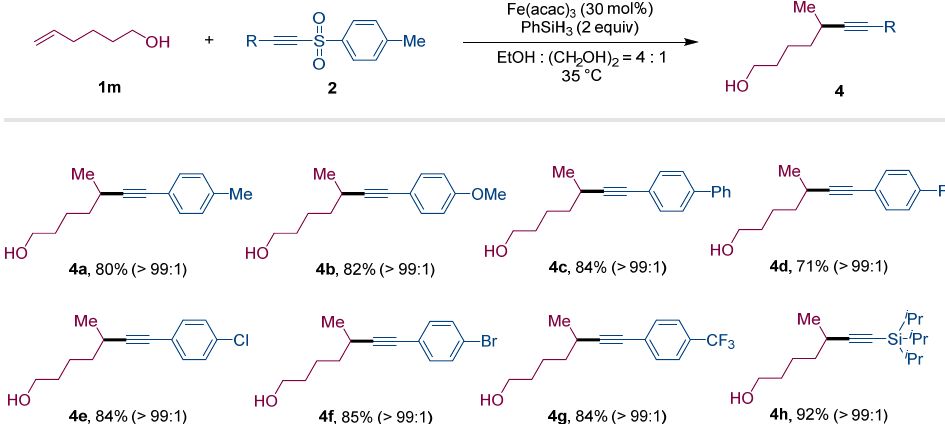
Figure 2. Substrate scope of acetylenic sulfones a . a Standard conditions: 1m (0.3 mmol, 1.5 equiv), 2 (0.2 mmol, 1.0 equiv), Fe(acac) 3 (30 mol%), PhSiH 3 (0.4 mmol, 2.0 equiv), in EtOH (0.8 mL) and